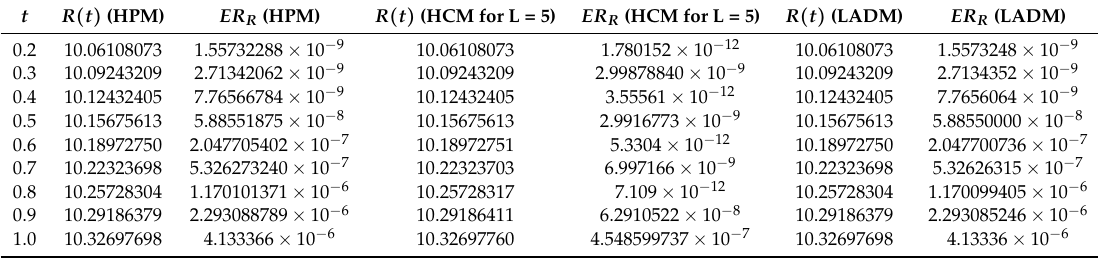
Table 3. The values of R ( t ) , and the residual errors ER R for HPM, HCM and